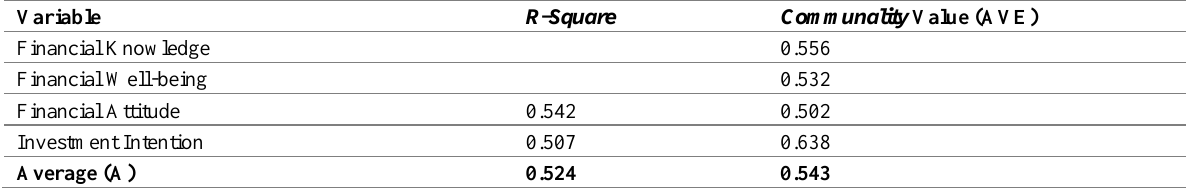
Table 4: Evaluation of Goodness of Fit